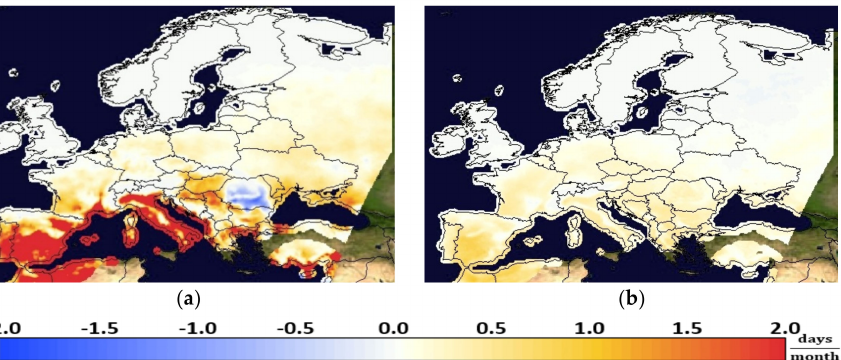
Figure 4. ( a ) Change in the number of days/month with mean temperature over 25 ◦ C observed (E-OBS) and ( b ) the related model bias (E-OBS—Model) between current and historic periods for summer